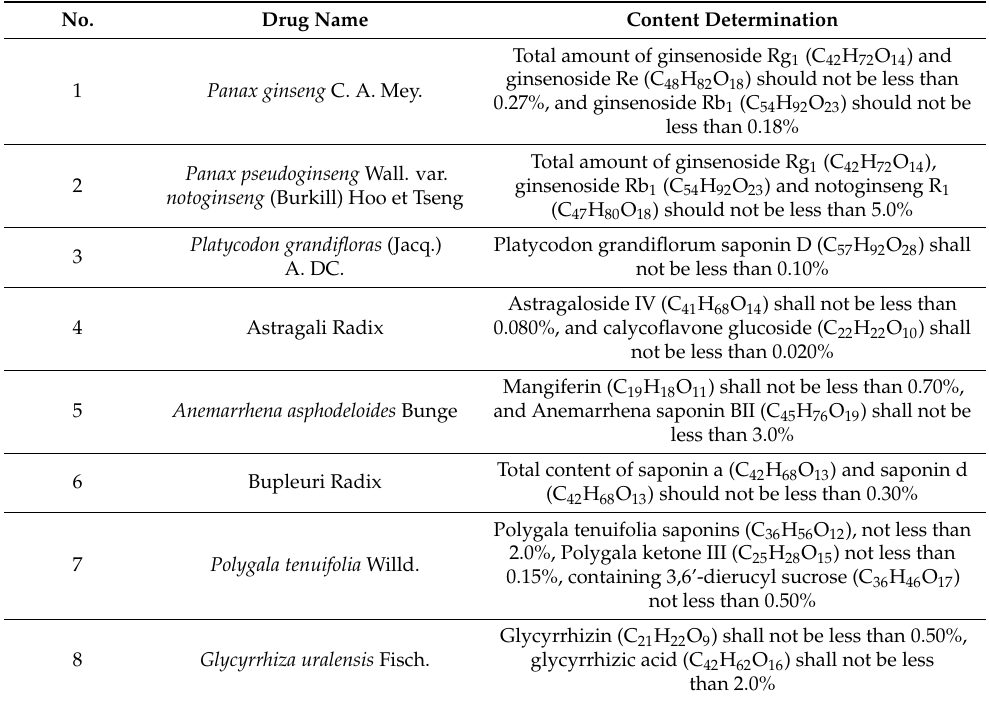
Table 2. Quality standard table of important medicinal materials mainly containing saponins in the 2020 Chinese